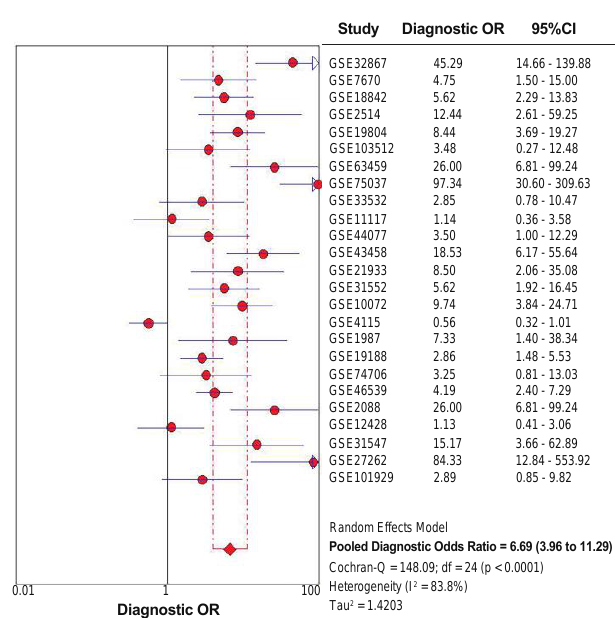
Figure 4. Summary receiver operator characteristic curve (sROC) and diagnostic odds ratio (OR), showing a moderate discriminative yield of SETDB1 mRNA expression for NSCLC. ( A ) Symmetrical summary receiver operator characteristic curve (sROC) based on 1140 NSCLC tissues and 952 non-cancerous tissues (25 GEO datasets). The size of the circle symbolizes the sample size of each study included in the meta-analysis. ( B ) Forest plot for diagnostic odds ratios in NSCLC diagnosis. The circles represent odds ratios for each dataset. The diamond represents the estimated overall effect, based on the meta-analysis random-effect method.